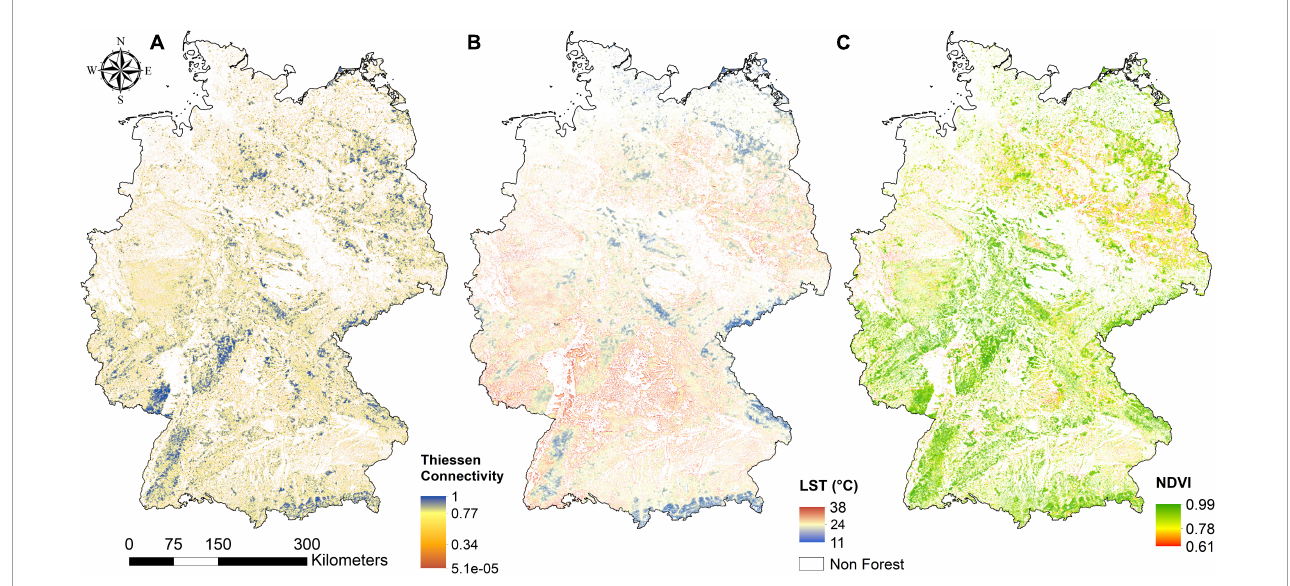
FIGURE2 Characteristics of tree-covered areas in Germany 2022 across the terrestrial ecoregions in terms of (A) forest fragmentation (Thiessen connectivity), (B) land surface temperature [land surface temperature (LST); MODIS Aqua MYD11A1] indicated as the per pixel mean of hot days ( ≥ 30 ◦ C) in 2022, and (C) forest vitality (NDVI; MODIS Aqua MYD13A2) indicated as the maximum value of the growing season May–September.